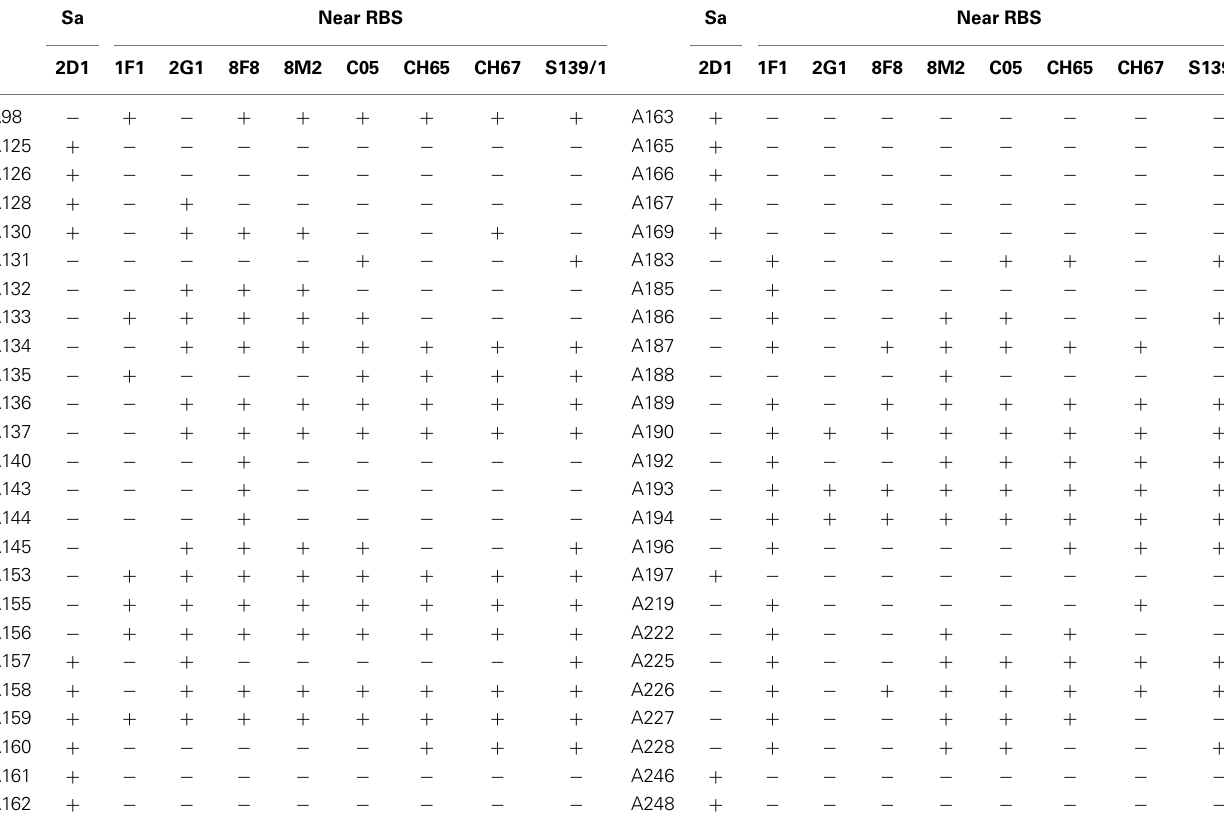
Table 3 | B-cell epitope overlap for nAbs targeting HA head region